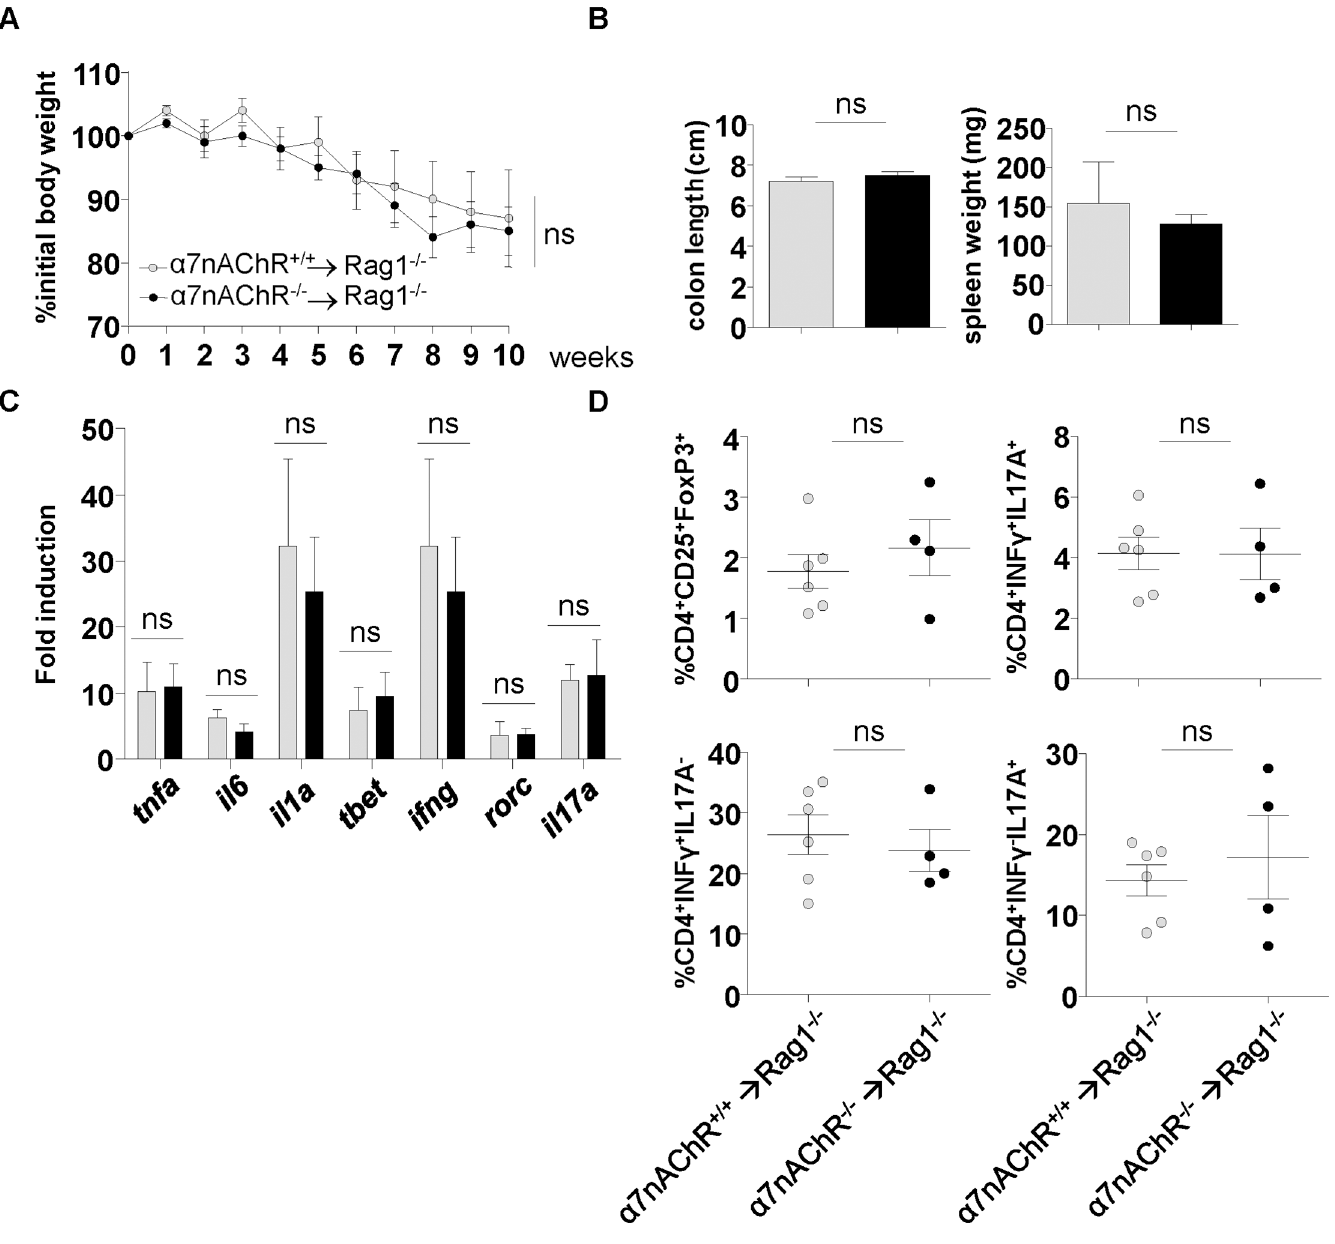
Figure 6. Lack of T cell–specific α 7nAChR signaling does not influence severity of T cell transfer induced colitis. Rag1 –/– mice were adop- tively transferred with naïve CD4 T cells isolated respectively from α 7nAChR +/+ or α 7nAChR -/- mice. (A) Body weight loss was followed over time in Rag1 -/- mice injected with α 7nAChR +/+ naïve T cells ( α 7nAChR +/+ → Rag1, gray) and in Rag1 -/- mice injected with α 7nAChR -/- naïve T cells ( α 7nAChR -/- → Rag1, black). Statistical significance was determined using a multivariate linear model after a post-hoc Bonfer- roni-Holm correction for body weight changes and stool consistency score (ns, not significant). (B) Ten weeks after T cells transfer, colon length and spleen weight were measured in α 7nAChR +/+ → Rag1 and α 7nAChR -/- → Rag1 mice. (C) Inflammatory gene expression was quantified via q-PCR in colonic tissue. tnfa , il6 , il1a , tbet , infg , rorc and il17a mRNAs were analyzed. Gene expression levels are shown relative to rpl32 mRNA expression. The frequencies of Th cells isolated from the colonic lamina propria were determined by flow cytom- etry. Gates were set on CD4 + cells. (D) Frequencies of Th cell subsets (IFN- γ + IL-17A - , IFN- γ + IL-17A + , IFN- γ - IL-17A + ) and Tregs (CD25 + FoxP3 + ). Dots represent individual mice. In addition, data are shown as mean ± SEM. Data are representative of 3 independent experiments. Statistical significance was determined with the unpaired Student t-test (ns, not significant) for colon length, spleen weight, gene expression level and flow cytometry